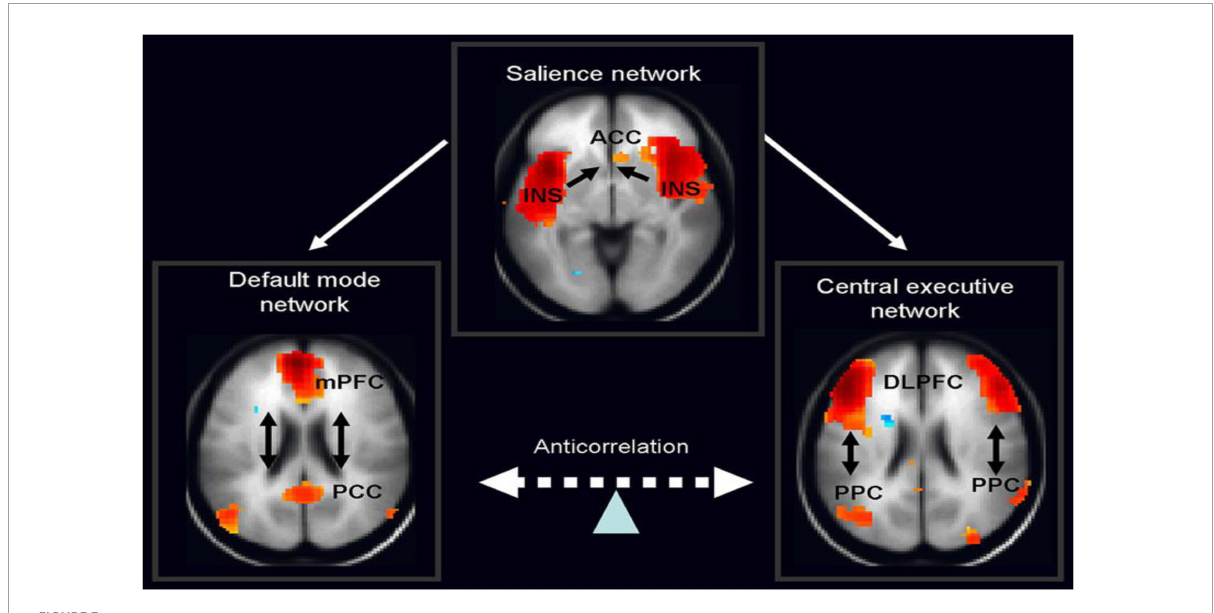
FIGURE3 The salience network is theorized to mediate switching between the default mode network (DMN) and central executive network (CEN) (adapted from Vossel et al., 2014, with